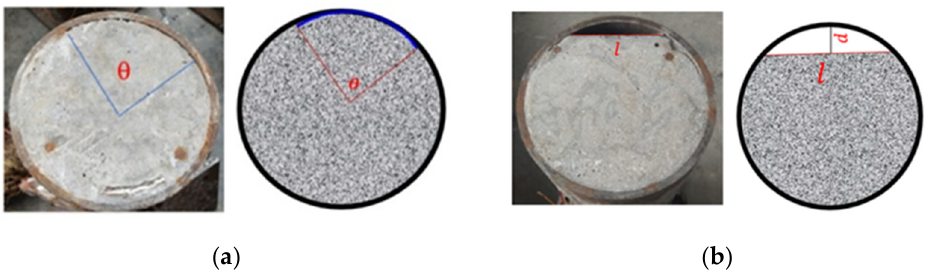
Figure 1. Cross-section of CFST column specimens with initial imperfections: ( a ) Interfacial gap; ( b ) Spherical-cap gap.